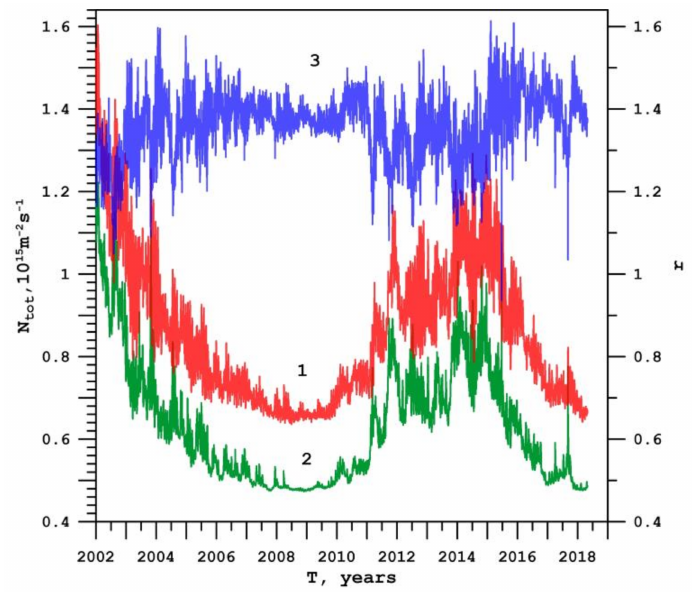
Figure 6. Time variations of the total flux of EUV radiation over 23–24 activity cycles according to calculations using the EUVT ( Line 1 ) and EUVAC ( Line 2 ) models. ( Line 3 )—their ratio r. However, the magnitude of the excess is not the same for different parts of the spectrum. Figure 7 represents the results of model calculations for fluxes in the lines of 30.4 nm (lines 1 and 2) and 102.6 nm (lines 3 and 4). Blue lines correspond to the EUVAC model, and red the EUVT model.